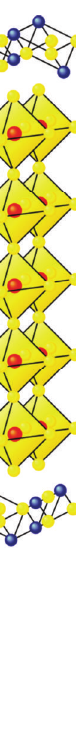
Figure 14: Crystal structure of Bi-layered perovskite A 2 Bi 4 Ti 5 O 18 with m = 5. strongly correlated -O-Ti-O-Ti-O- chain plays an important role for the appearance of ferroelectricity in bulk BaTiO 3 [26], the -O-Ta-O-Ta-O- chain along the pseudo-tetragonal c axis is interrupted by the existence of semiconductor Bi 2 O 2 layers in SBT. The strength of interaction between Ti ion and adjacent O ions is half, but antiferroelectric in the